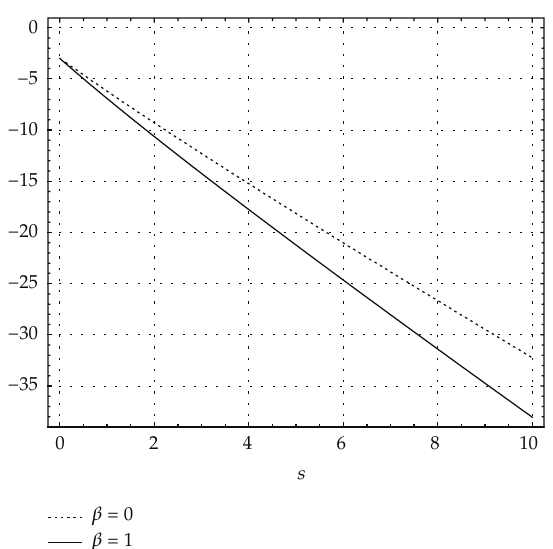
Figure 5: The pressure gradient (cid:3) f (cid:2)(cid:2)(cid:2) (cid:3) 1 (cid:4)(cid:4) for the axisymmetric and two-dimensional